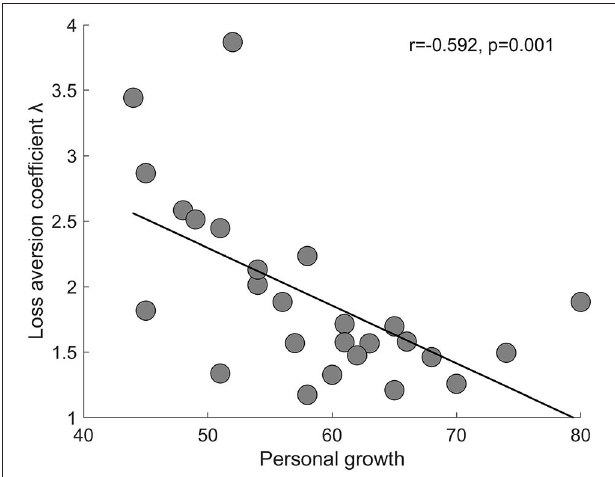
FIGURE 4 | Scatter plot (with a regression line) of the association between LA coefficient λ and performance reward (JPY). Each circle represents a subject. n =